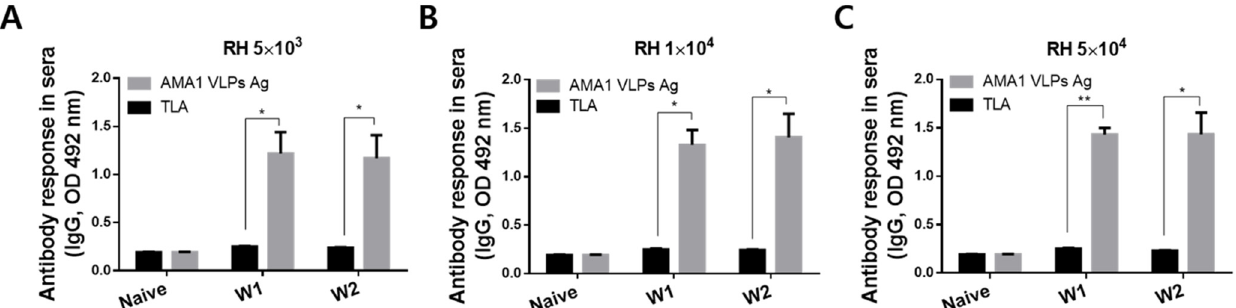
Figure 3. Reactivity of T. gondii RH infection-induced IgG antibody to AMA1 VLPs antigen. Mice were orally infected with 5 × 10 3 ( A ), 1 × 10 4 ( B ), or 5 × 10 4 ( C ) tachyzoites of the T. gondii RH strain. Sera were collected at 1 and 2 wpi to assess antigen-specific antibody responses. Data are presented